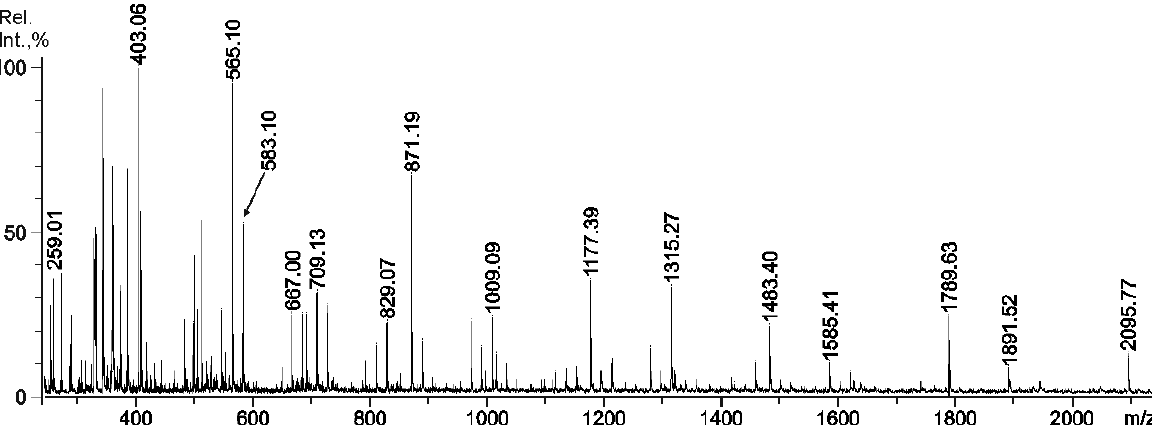
Figure 1. Negative-ion MALDI-TOFMS of the oligosaccharide mixture obtained by acid hydrolysis from RF/CRG poly- saccharide. Table 2. Structural features of some oligosaccharides, obtained by mild acid hydrolysis of high- molecular-weight RF/CRG fraction, which was not hydrolyzed by κ -carrageenase from marine bac- terium P. carrageenovora.